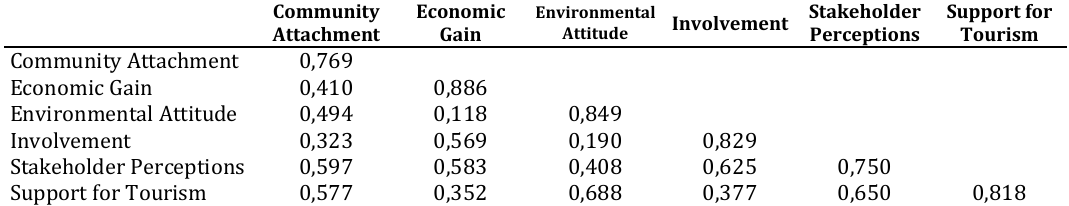
Table 4:Discriminant validity fornell-larcker criterion